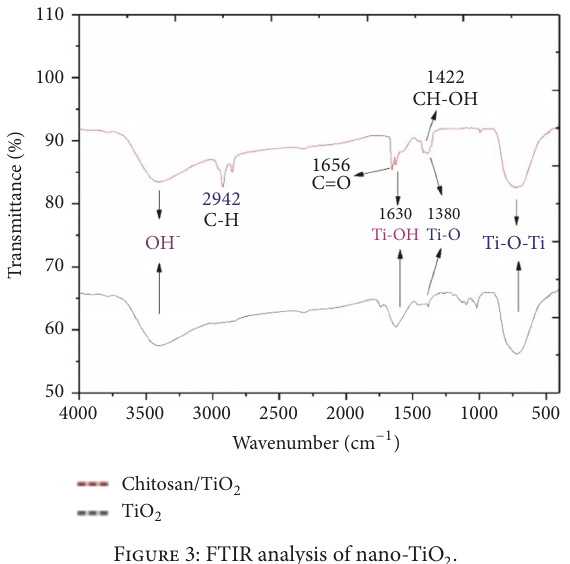
Figure 3: FTIR analysis of nano-TiO 2 .